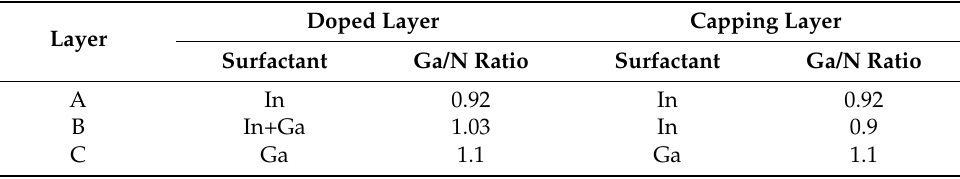
Table 1. Type of surfactant (In, Ga or mixture of the two) and Ga/N ratio used during growth of doped and capping layers for regions A, B and C marked in Figure 2. In flux and nitrogen flux (determining the growth rate) were kept constant for all three layers at 1 µ m/h and 0.85 mm/h,